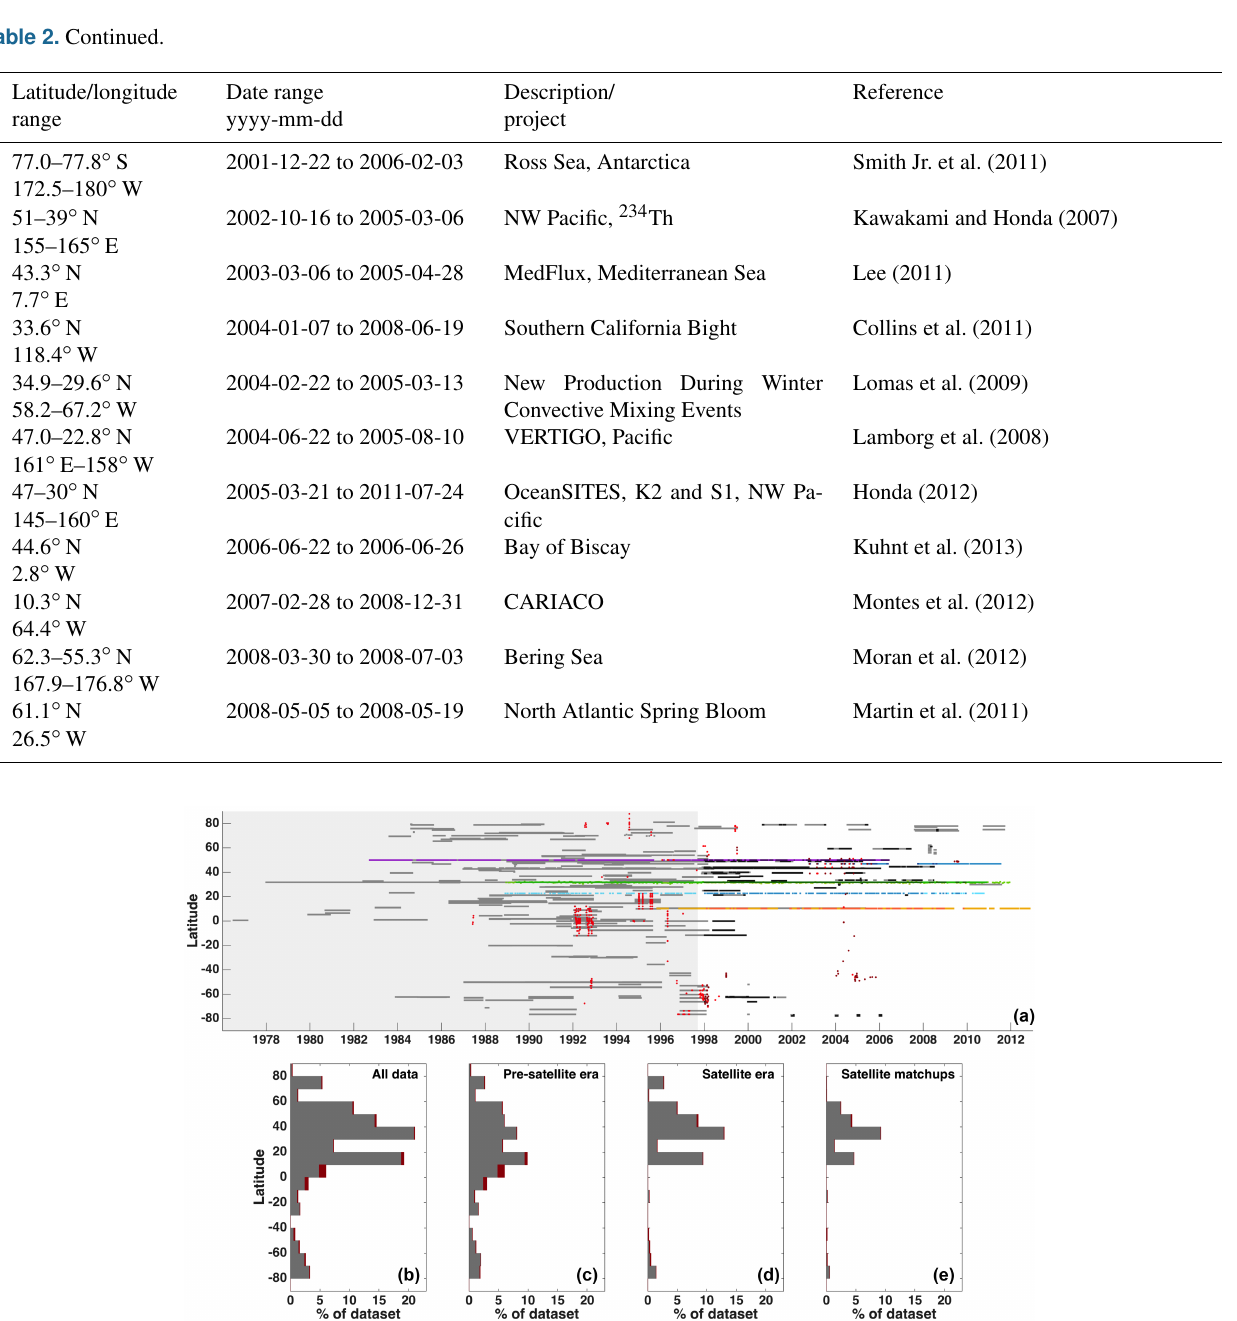
Figure 2. Latitudinal distribution of POC flux observations. (a) Temporal distribution showing observations prior to (shaded area) and during (right panel) the satellite era. The length of each grey bar represents a sediment trap deployment (darker bars indicate observations coincident with satellite NPP and S fm ); note some bars may overlap. Time series locations are denoted by color as in Fig. 1. 234 Th data are differentiated in all subplots (red). (b) The percentage of total observations binned by every 10 ◦ of latitude. (c) Observations prior to the continuous satellite era (before September 1997). (d) Observations collected during the continuous satellite era (beginning September 1997). (e) Observations with coincident satellite imagery within the same month of